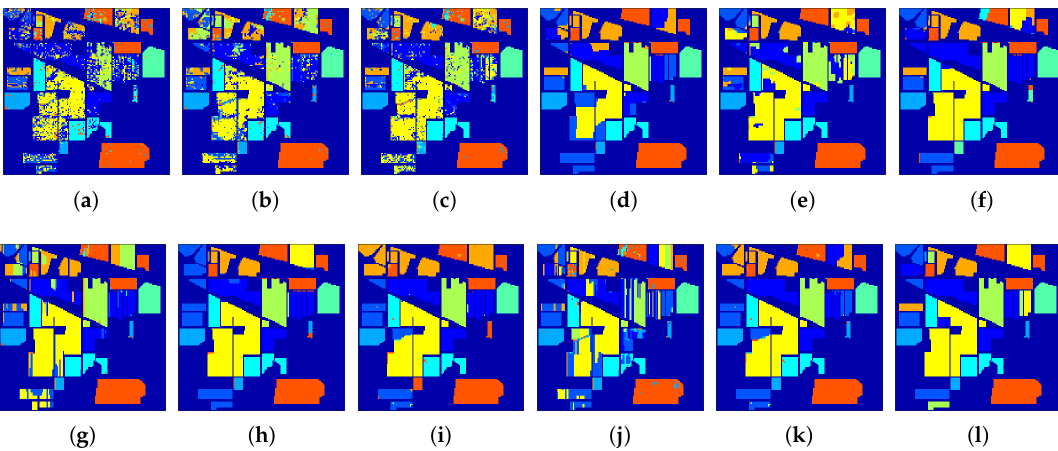
Figure 10. Indian Pines classification maps generated from different methods. ( a ) SunSAL, ( b ) MLR, ( c ) LC, ( d ) MRFG_a , ( e ) MRFG, ( f ) MRF_a, ( g ) MRF_p, (h) MRFL, ( i ) CRF_a, ( j ) CRF_p, ( k ) CRFL, ( l ) Ground